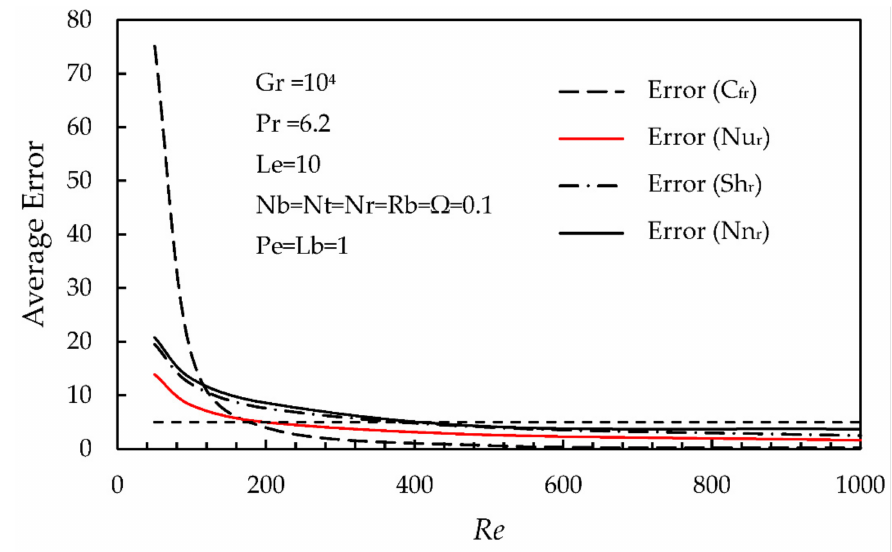
Figure 9. The average error versus the Reynolds number, Re , for the reduced skin friction coeffi- cient, C fr , the reduced Nusselt number, Nu r , the reduced Sherwood number, Sh r , or the reduced concentration of microorganisms, Nu r .